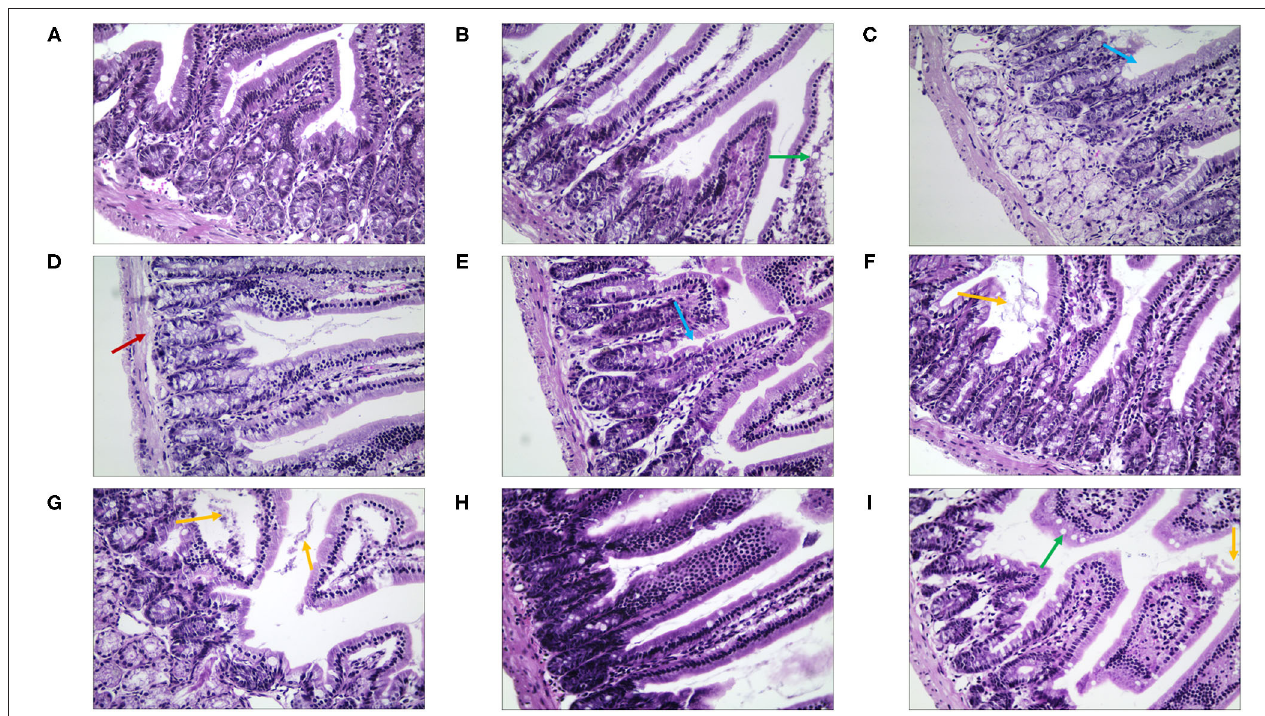
FIGURE 8 | The morphological and histopathological changes (H&E, × 50 magnification) of the duodenum tissues in diarrhea mice. (A) Normal control (NC) group, (B) model control (MC) group, (C) positive control (PC) group, (D) QJC group, (E) quercetin group, (F) kaempferol group, (G) luteolin group, (H) scutellarein group, and (I) stigmasterol group. Yellow arrow: exfoliated mucosal epithelial cells; blue arrow: intestinal crypts; green arrow: goblet cells; red arrow: loose connective tissue; n = 5 per